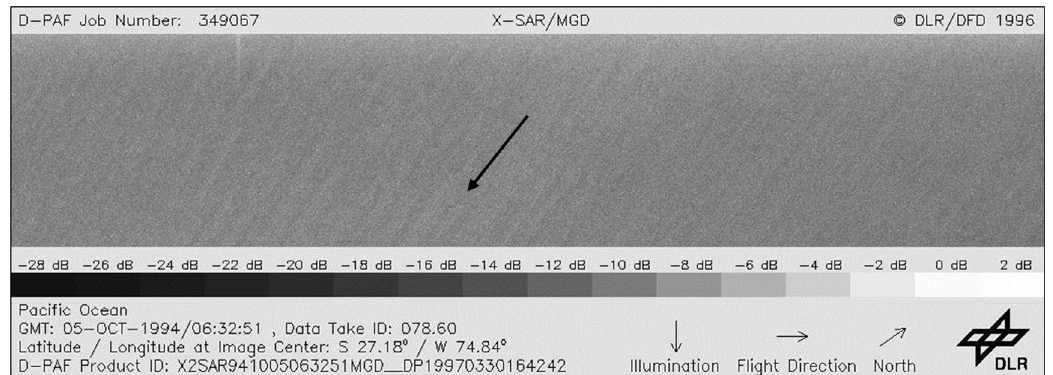
Figure 1. An example of X-band Synthetic Aperture Radar (X-SAR) data acquired over the Pacific Ocean (source: German Aerospace Center). The black arrow parallel to the linear wind streaks indicates the wind direction without 180° ambiguity.